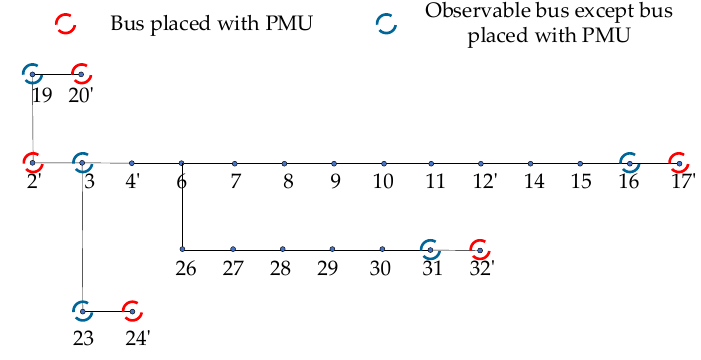
Figure 3. Compressed IEEE 33 bus system.